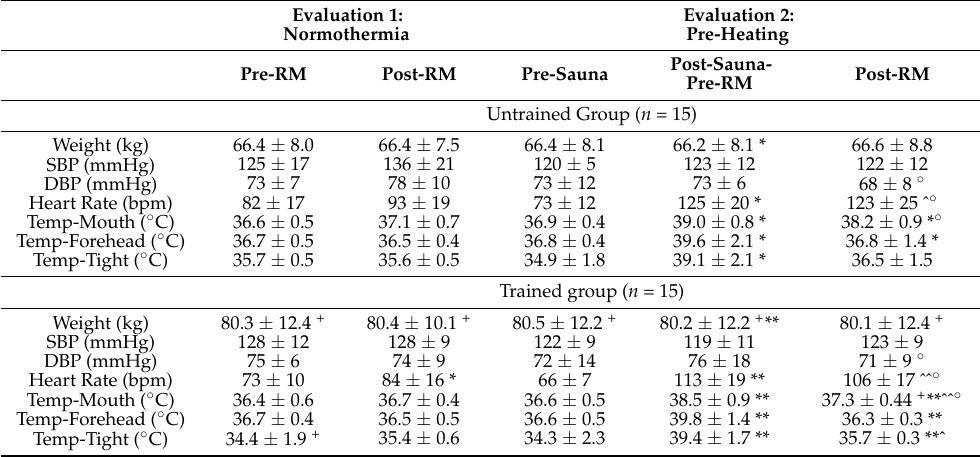
Table 2. Physiological effects of strength evaluation and sauna